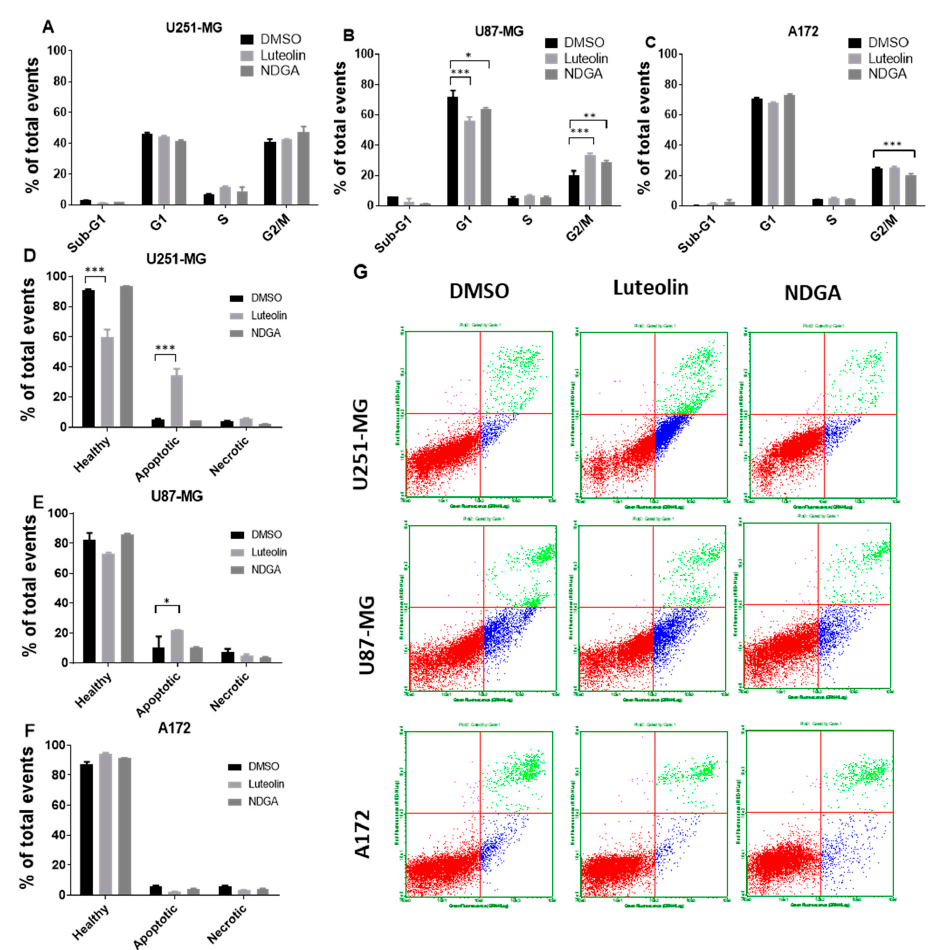
Figure 5. Flow cytometer analysis of the cell cycle and apoptosis. Cells were treated with luteolin